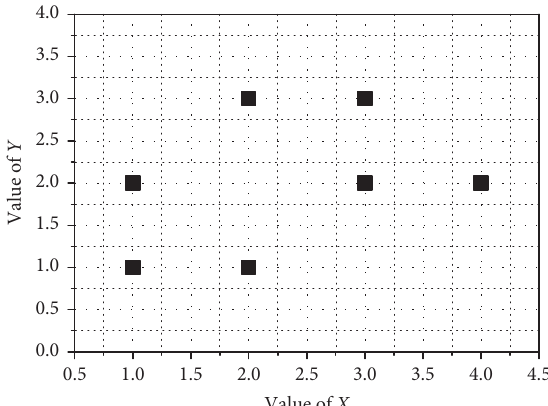
Figure 11: Clustering combination points of hidden